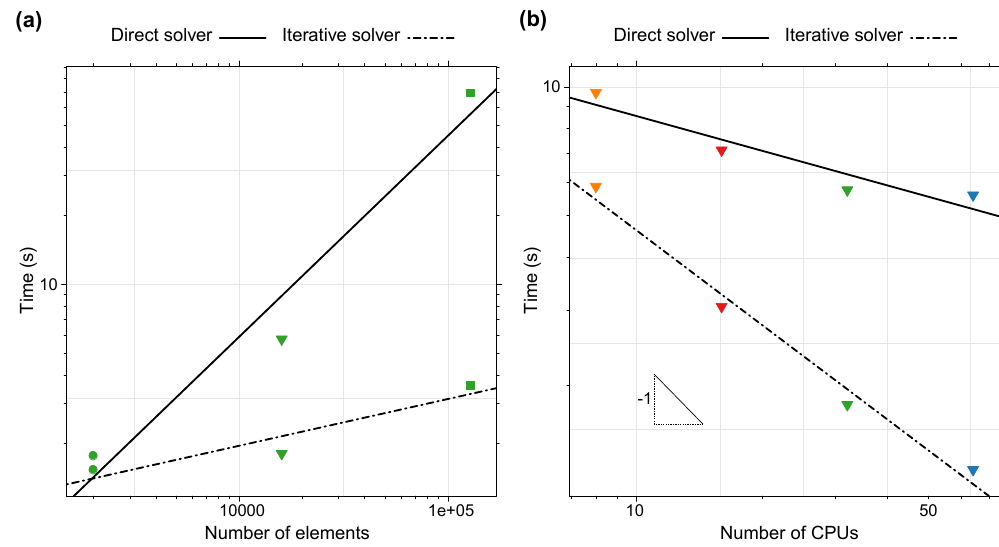
Figure 8. Scalability of the default ISSM solver (MUMPS) compared with a preconditioned iterative method (PC = bjacobi, KSP = cg) for ISMIP-HOM Experiment A. (a) Weak scalability of solvers using a constant ratio of 500 elements per CPU; ideal weak scalability is represented by a horizontal slope. (b) Strong scalability of solvers for a 16000-element model; ideal strong scalability is represented by a slope equal to − 1. Timing results include the CPU time associated with assembling the stiffness matrix and load vector, solving the system of equations, and updating the input from the